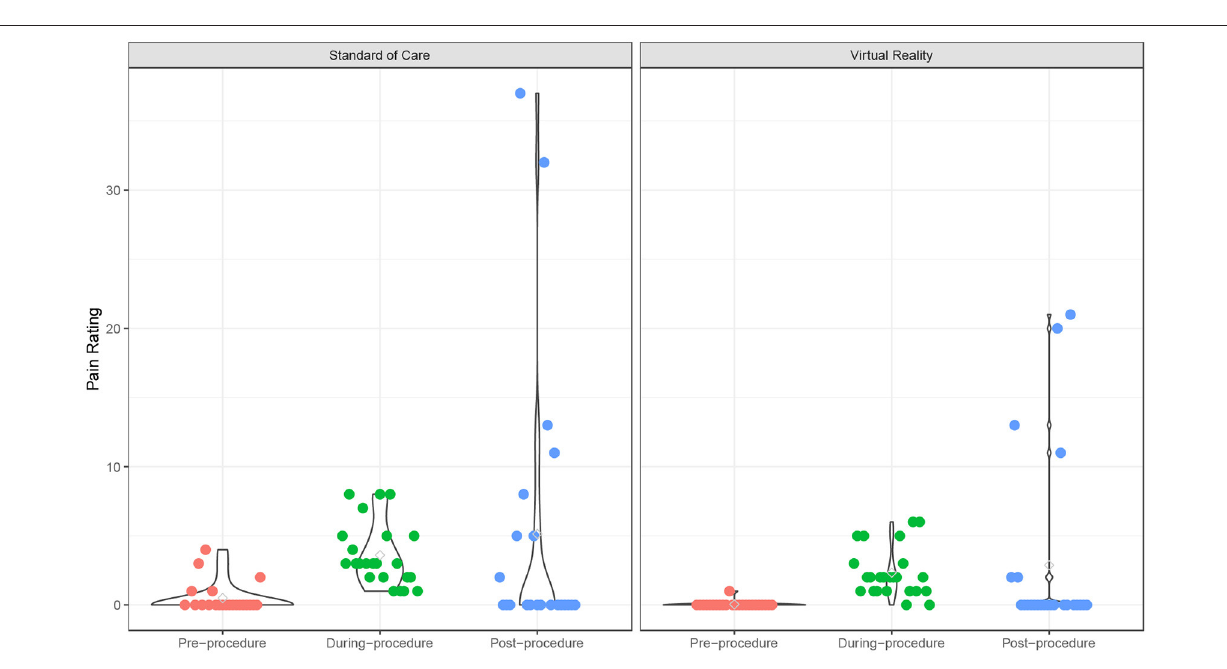
during phlebotomy. VR participants showed a greater decrease in anxiety and fear from baseline to post- procedure than SOC